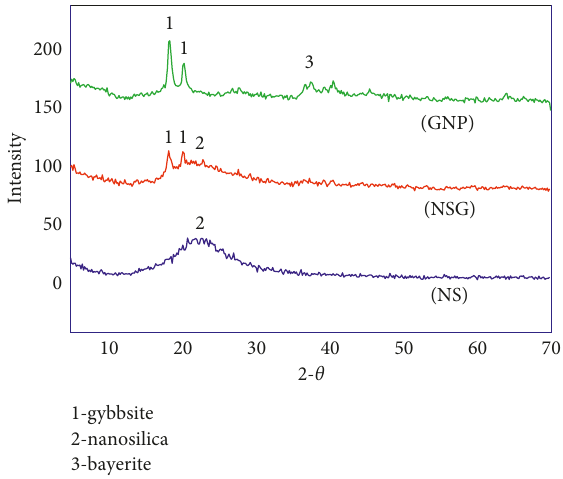
Figure 3: The XRD patterns of NS, GNPs, and the NSG